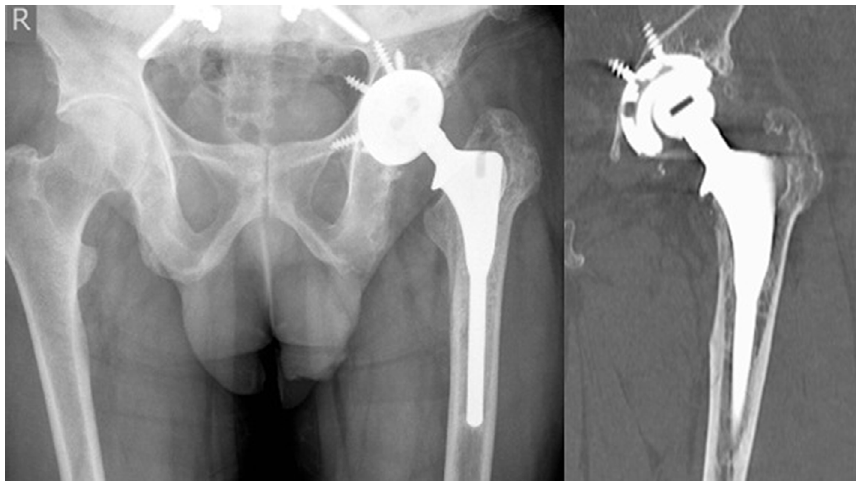
Figure 1. Plain radiograph shows an undisplaced proximal femur periprosthetic fracture involving lesser trochanter. CT shows eccentric wear of the articular surface.